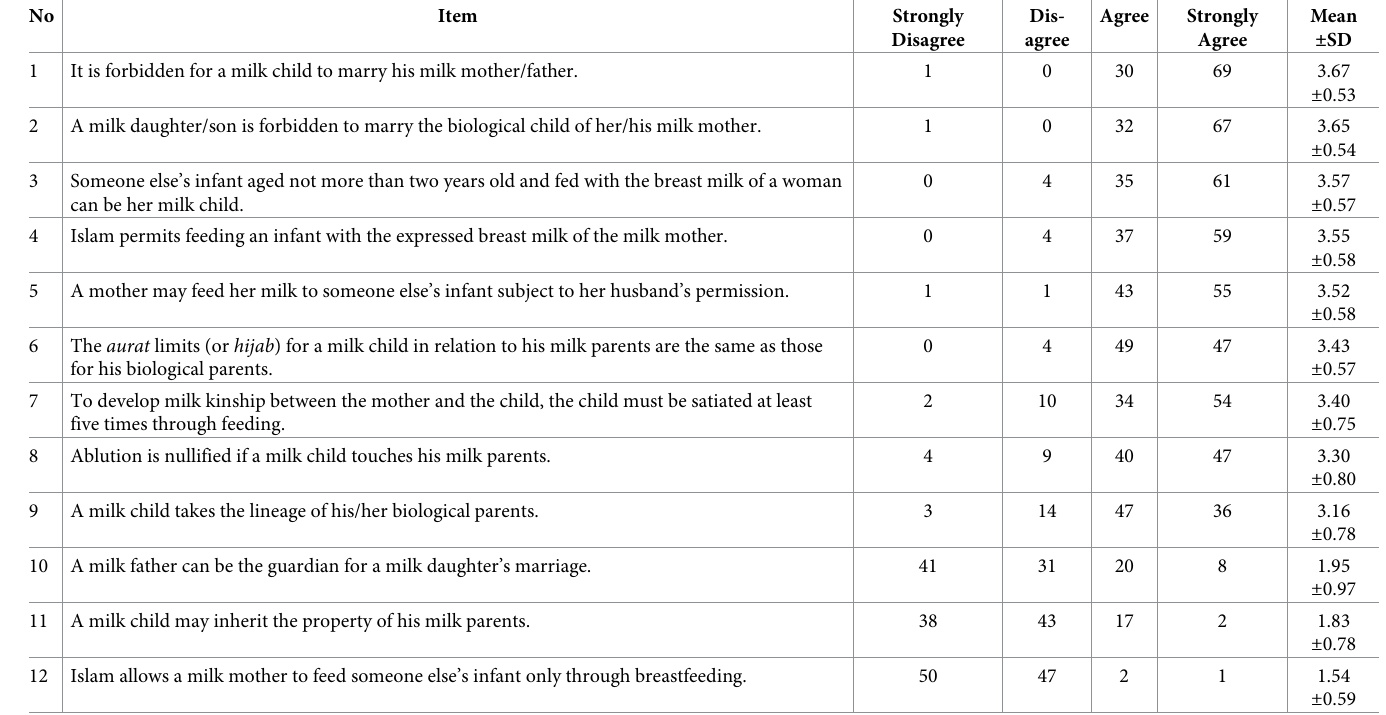
Table 2. Understanding of wet nursing in Islamic